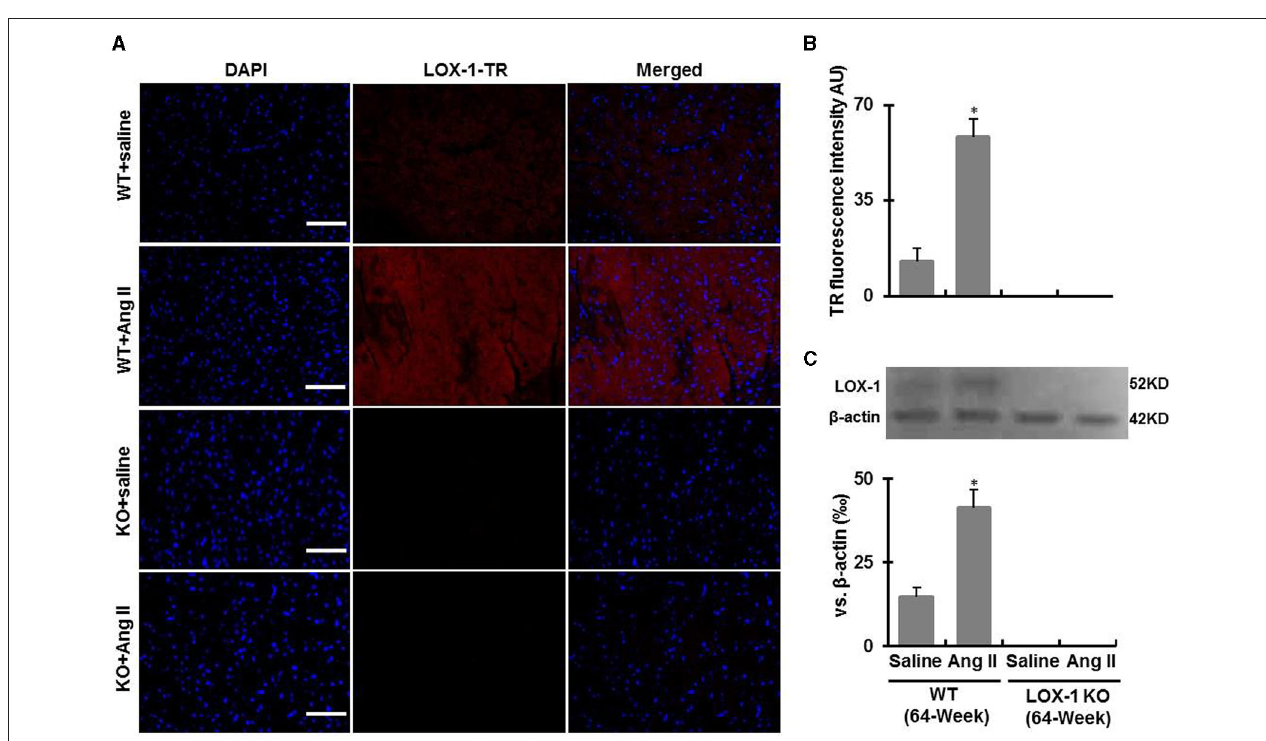
FIGURE 2 | LOX-1 expression in the hearts of each group of mice following infusion with Ang II or saline for 4 weeks. (A) Representative immunostaining images show LOX-1 expression in the hearts of each group of mice following Ang II infusion; (B) Quantitative data of immunostaining images; (C) Western blotting data show LOX-1 expression in the hearts of each group of mice following Ang II infusion. n = 6 /group. * P < 0.05, vs. WT + saline group. Scale bars represent 50 µ m.